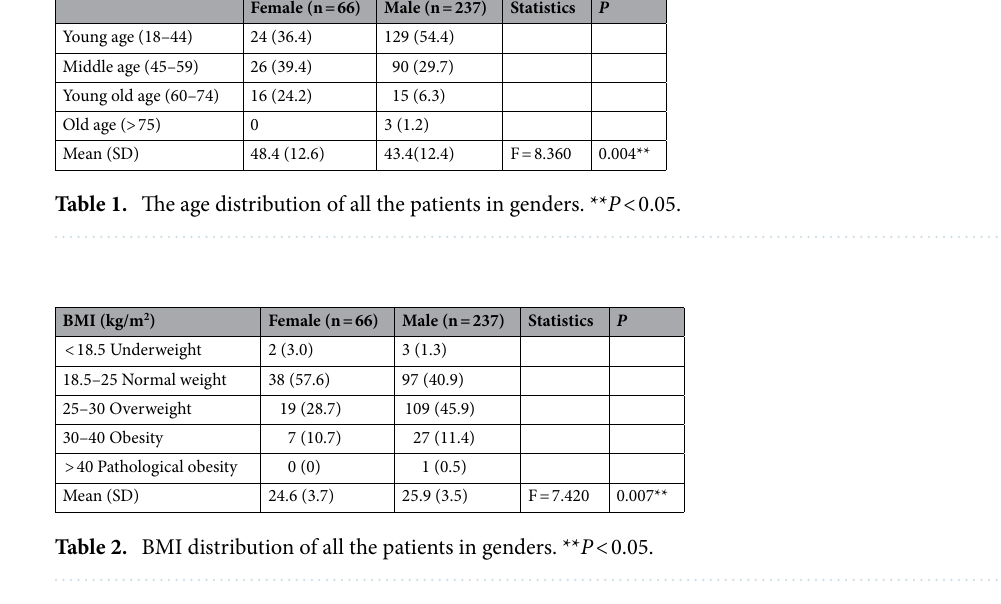
According to univariate and multivariate logistic regression analyses (Tables 3 and 4), compared with female patients with OSAS, male patients were taller (157.5 ± 5.0 cm, versus 169.8 ± 6.0 cm, respectively) and heav- ier (61.1 ± 9.6 kg versus 74.9 ± 11.5 kg, respectively). Male patients had higher systolic blood pressure in the morning (119.4 ± 13.6 mmHg versus 124.3 ± 16.1 mmHg, respectively), shorter duration of slow wave sleep (SWS) (52.7 ± 41.5 min versus 37.8 ± 27.3 min, respectively), more micro-arousal events (100.1 ± 77.0 versus 161.2 ± 125.5, respectively), more complex apnea events (2.7 ± 6.2 versus 18.2 ± 46.3, respectively). Apnea–hypo- pnea index (AHI) during total sleep time (TST) was greater in males than in females (24.3 ± 19.4 min versus 33.9 ± 25.5 min, respectively). TST was similar in male and female patients (455.1 ± 68.7 min versus 451.7 ± 69.8 min, respectively). There were no gender differences in REM sleep stage, N 1 and N 2 sleep duration (67.4 ± 30.8 min versus 71.9 ± 28.3 min, respectively, 331.5 ± 67.8 min versus 359.8 ± 240.6 min, respectively). Sleep latency of N1 and N2 was similar in females and males (14.1 ± 15.4 min versus 9.4 ± 17.3 min, 23.9 ± 29.9 min versus 16.7 ± 24.1 min, respec- tively). There was no significant gender difference of sleep efficiency (85.6 ± 10.5% versus 86.3 ± 12.1%, respec- tively). Mean and minimum oxygen desaturation were similar between genders (95.6 ± 1.7% versus 95.9 ± 2.0%, 78.7 ± 14.1% versus 82.6 ± 8.8%).